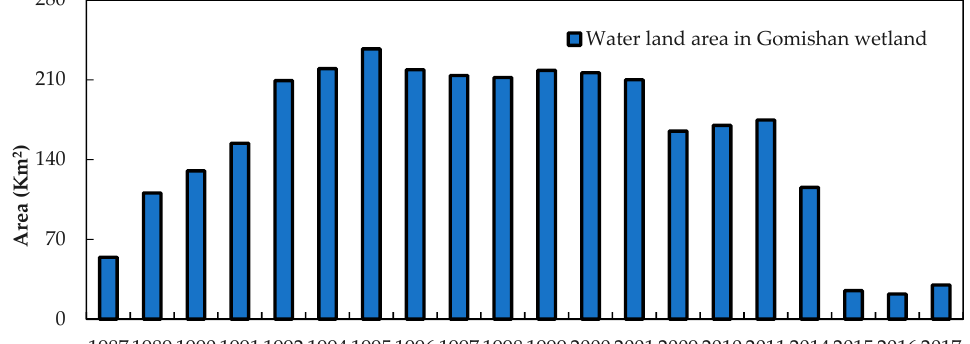
Figure 12. The water land area in the Gomishan wetland between 1987 to 2017.